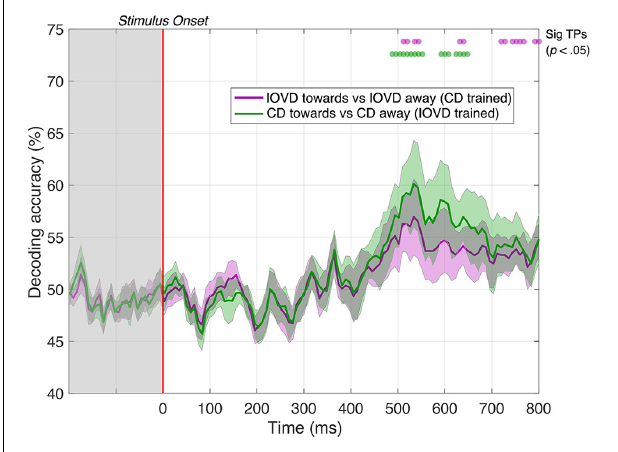
FIGURE 7 | Pairwise decoding accuracy of a cross-trained decoder across 125 time points, comparing between toward and away directions for CD and IOVD stimuli. The purple line represents decoding accuracy for IOVD toward vs IOVD away after decoder is trained using CD direction data. The green line represents decoding accuracy for CD toward vs CD away after the decoder is trained using IOVD direction data. Purple and green dots indicate time points when the Bonferroni-corrected t -tests were significant for the two conditions ( p < 0.05). Shaded error bars represent ± 1SE of the bootstrapped mean (1000